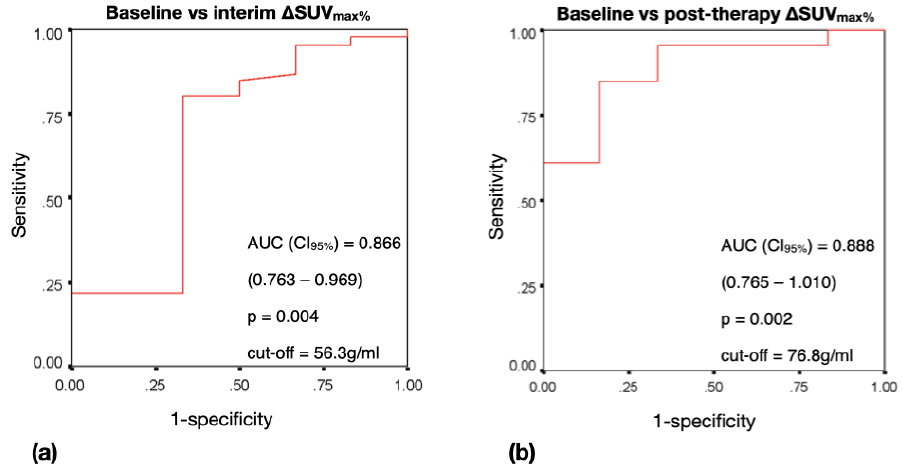
Figure 2. ROC curves for therapy response prediction at 24 months based on ΔSUV max% at interim ( a ) and post-therapy PET-CT ( b ). ( a ) and post-therapy PET-CT ( b